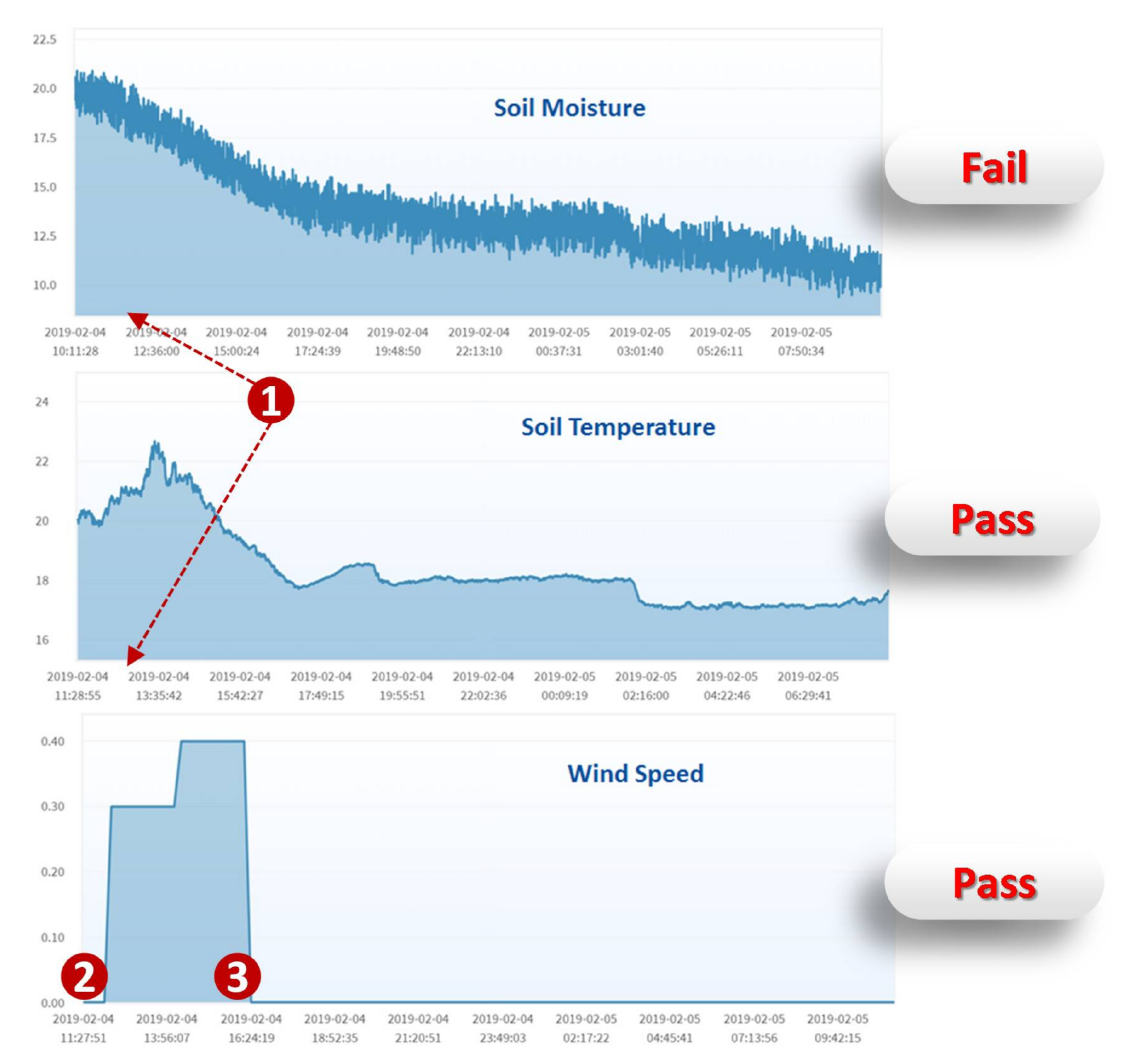
Figure 20. Time series charts of the greenhouse